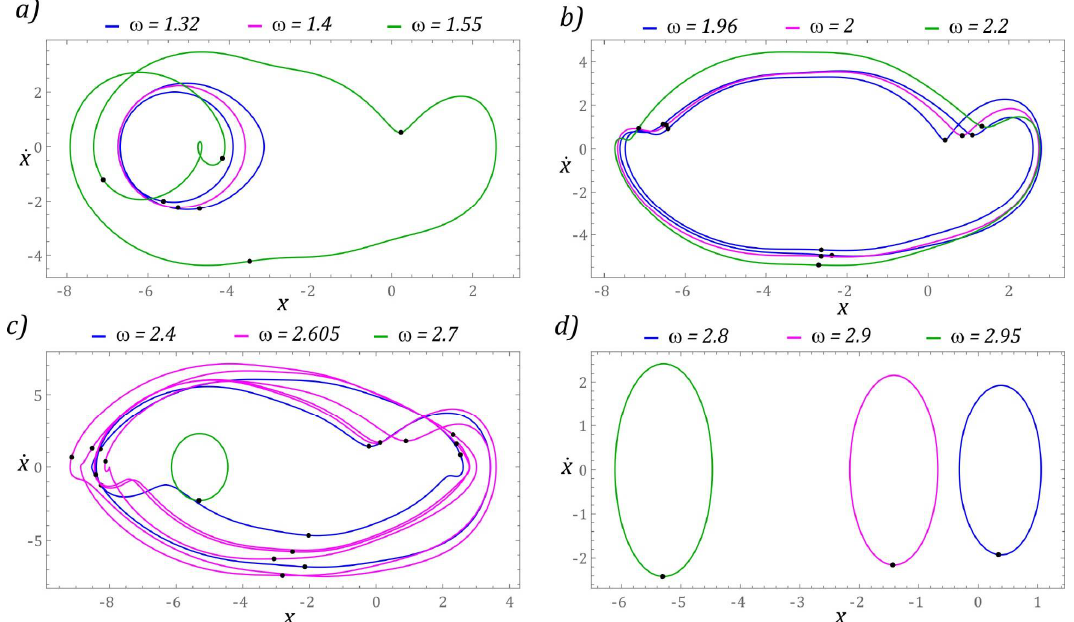
Figure 13. Sample graphic images of periodic solutions. The cases ( a – d )show the selected solutions for increasing ω . The corresponding Poincaré maps with multiple black points ( a – c ) indicate higher period solutions.